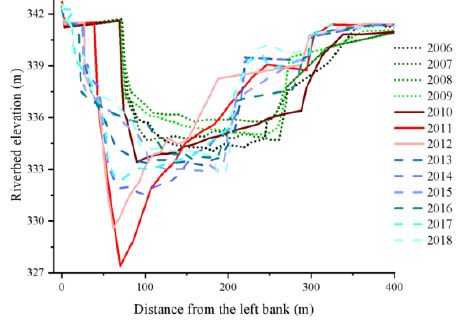
Figure 4. 2006 – 2018 Huaxian station post − flood cross − section. Figure 4. 2006–2018 Huaxian station post-flood cross-section.